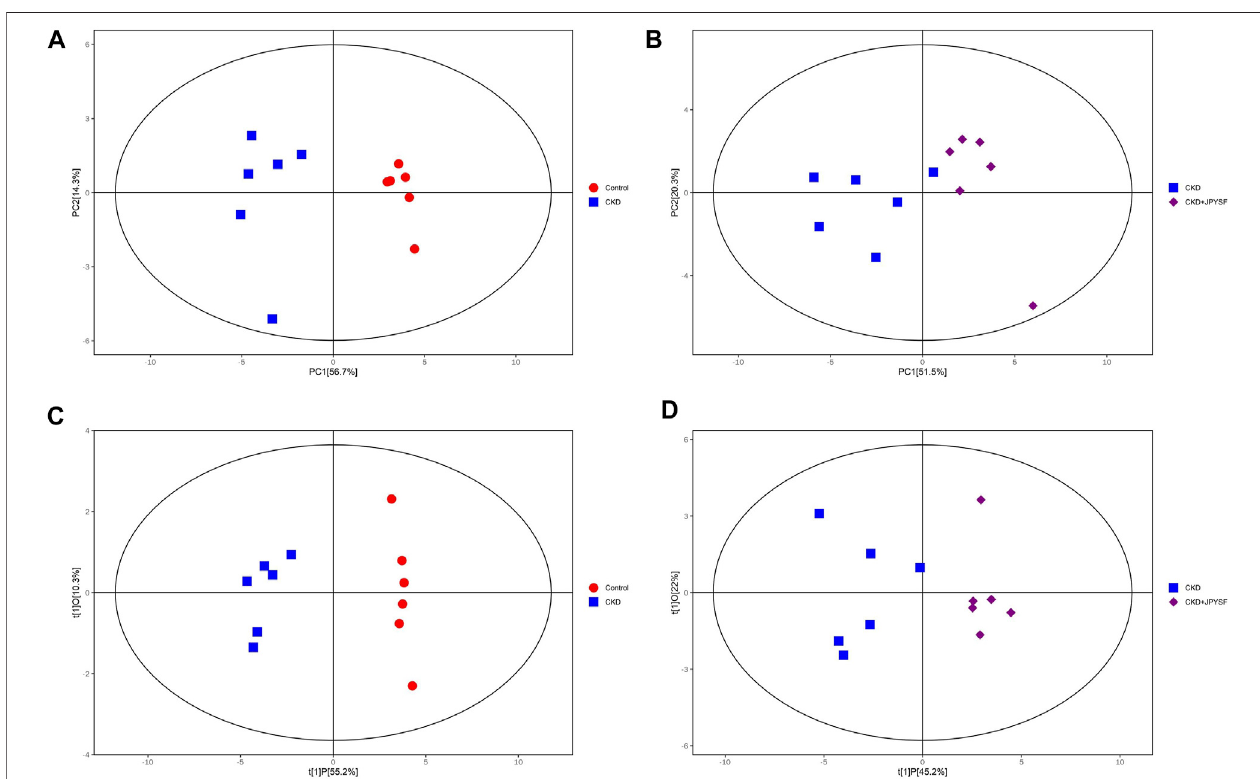
FIGURE 3 | The score scatter plots of PCA and OPLS-DA model. (A) PCA score plot of the control group versus the CKD group. (B) PCA score plot of the CKD groupversustheCKD+JPYSFgroup. (C) OPLS-DAscoreplotofthecontrolgroupversustheCKDgroup. (D) OPLS-DAscoreplotoftheCKDgroupversustheCKD+ JPYSF group. The red circle represents the control group, the blue square represents the CKD group, and the purple diamond represents the CKD + JPYSF